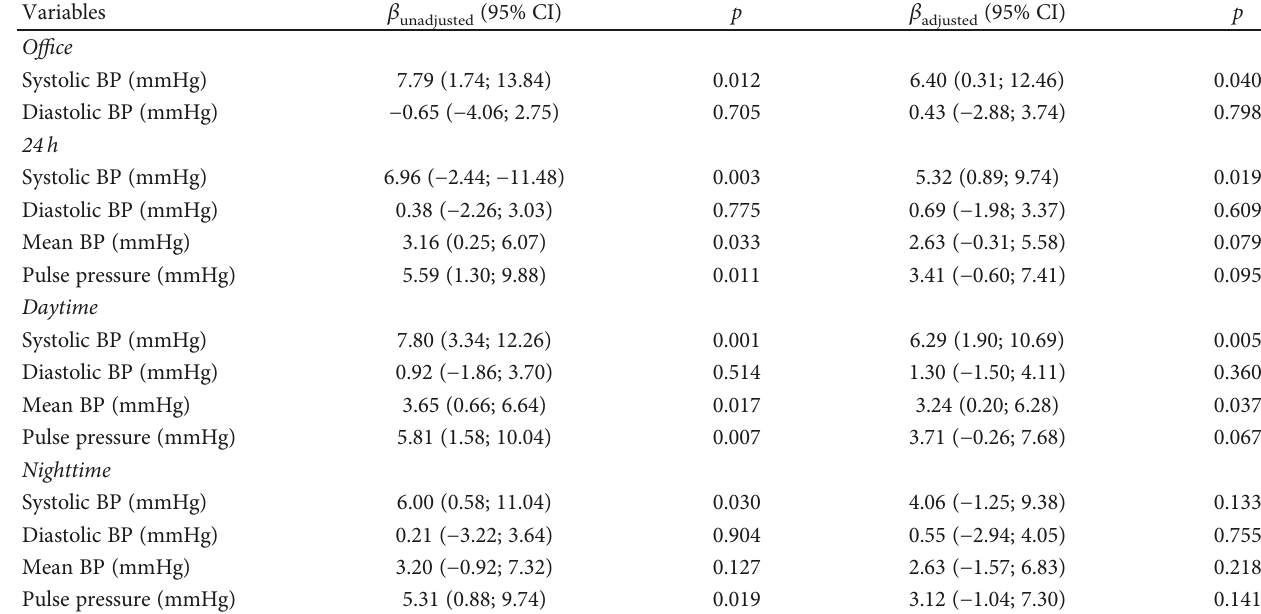
Table 4: Linear regression between steps count per day (lower tertile versus the two upper tertiles) and blood pressure pro fi le.